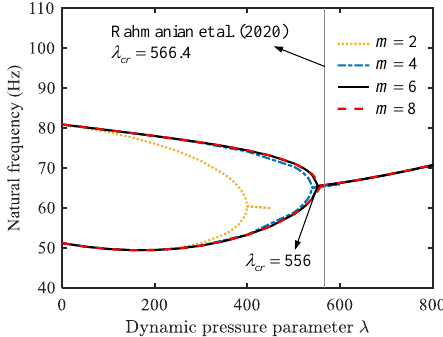
Figure 2. Mode convergence and comparison study for the aerothermoelastic analysis with result reported in the literature [32].